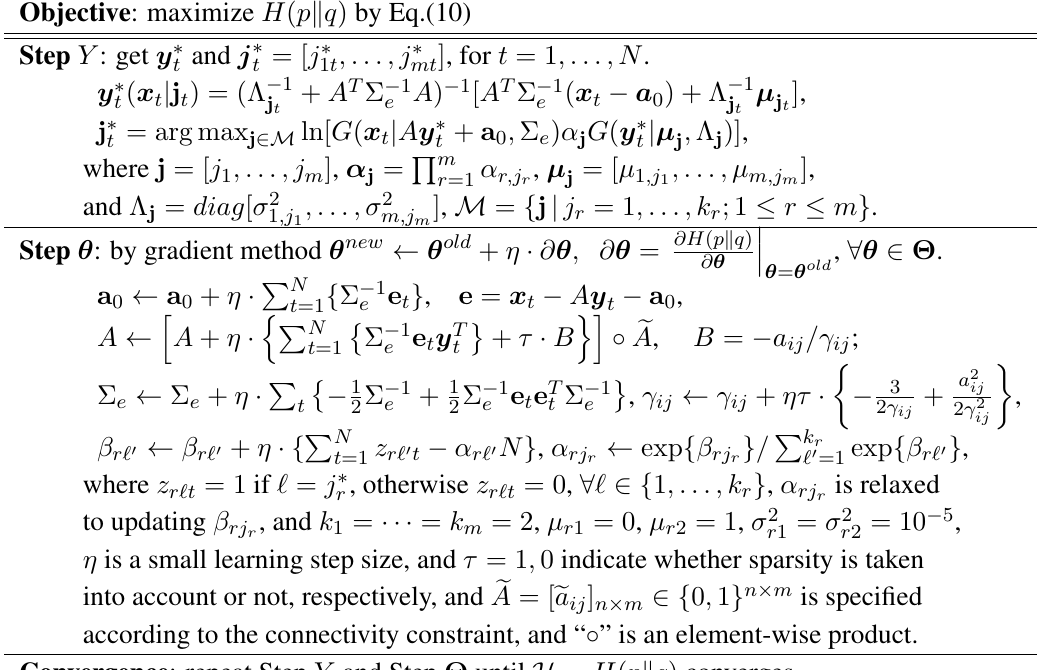
Table 4: The BYY-BFA